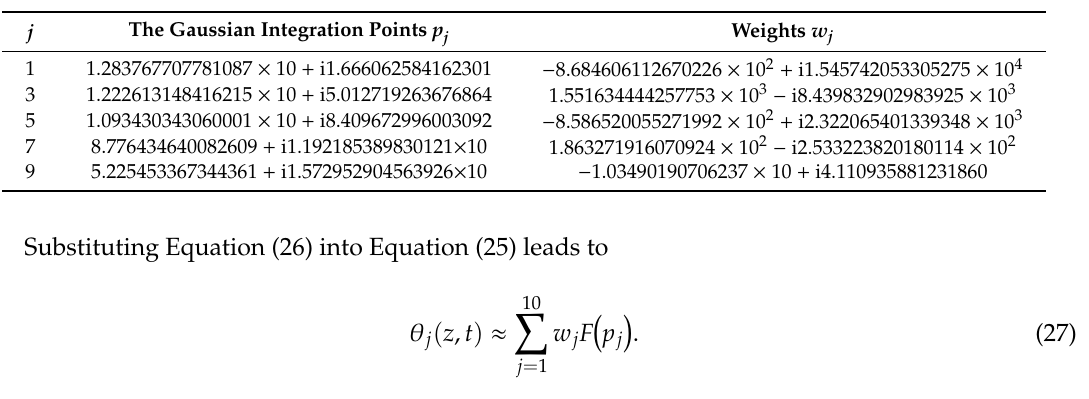
Table 1. The Gaussian integration points ( p j ) and the weight coe ffi cients of the Gaussian integration points ( w j )